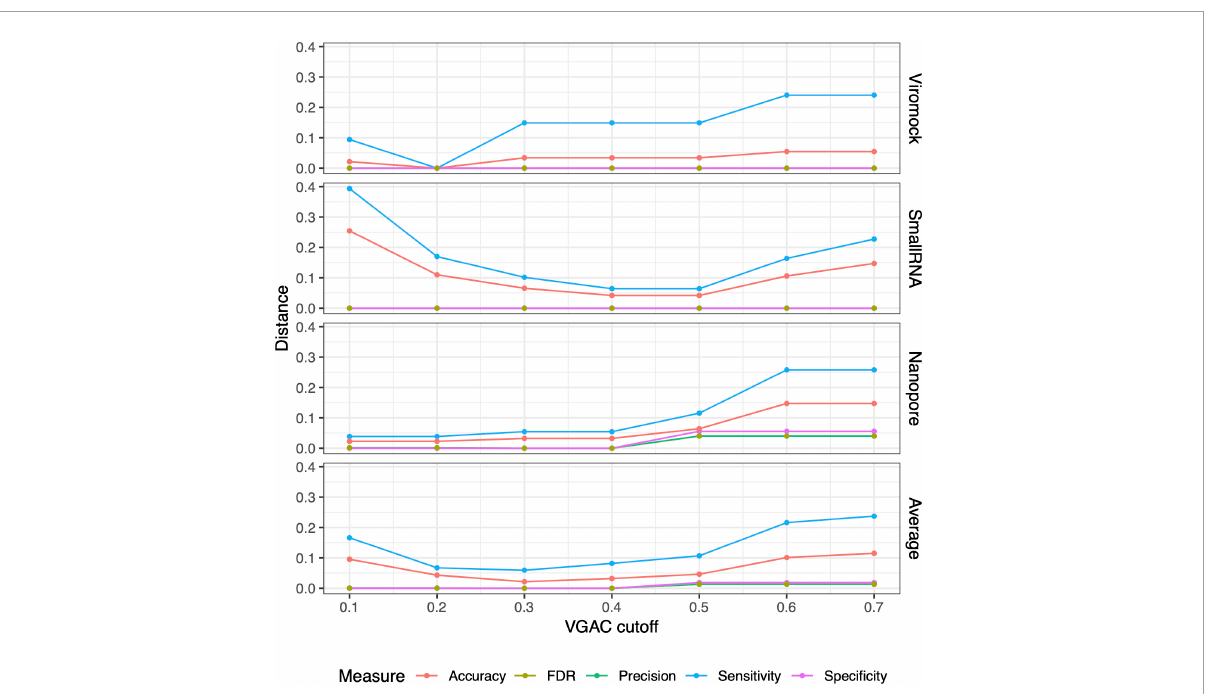
FIGURE6 Distances between measures from external datasets. Comparison of the measures (accuracy, FDR, precision, sensitivity, and specificity) obtained under different cutoffs of VGAC (viral genome assembly coverage) with the measures obtained for the identification of replicases under the 80/80 schema. Comparison was carried out in terms of the distance between the measures according to “Materials and methods.” For a detailed description refer to Supplementary Table 10